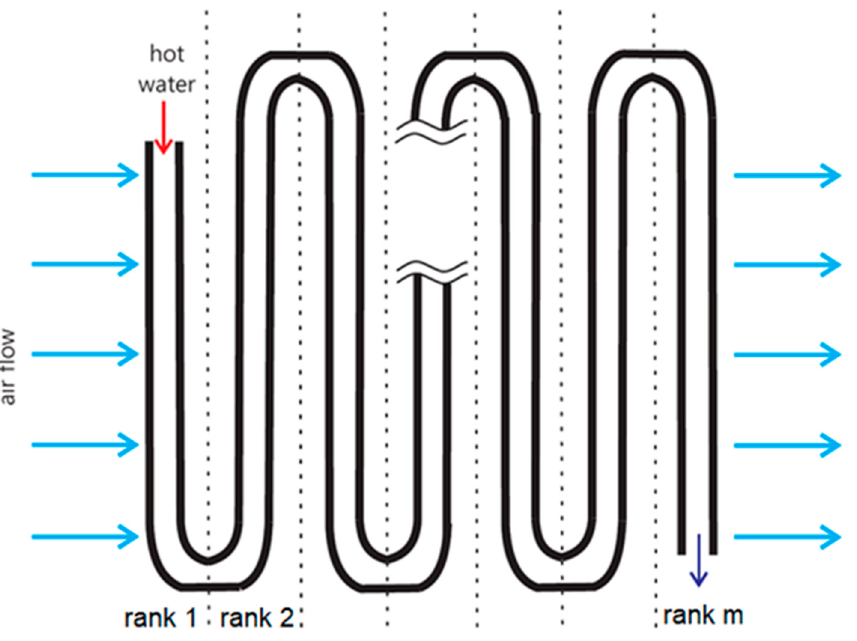
Figure 1. Sketch of the heat exchanger with its ranks.